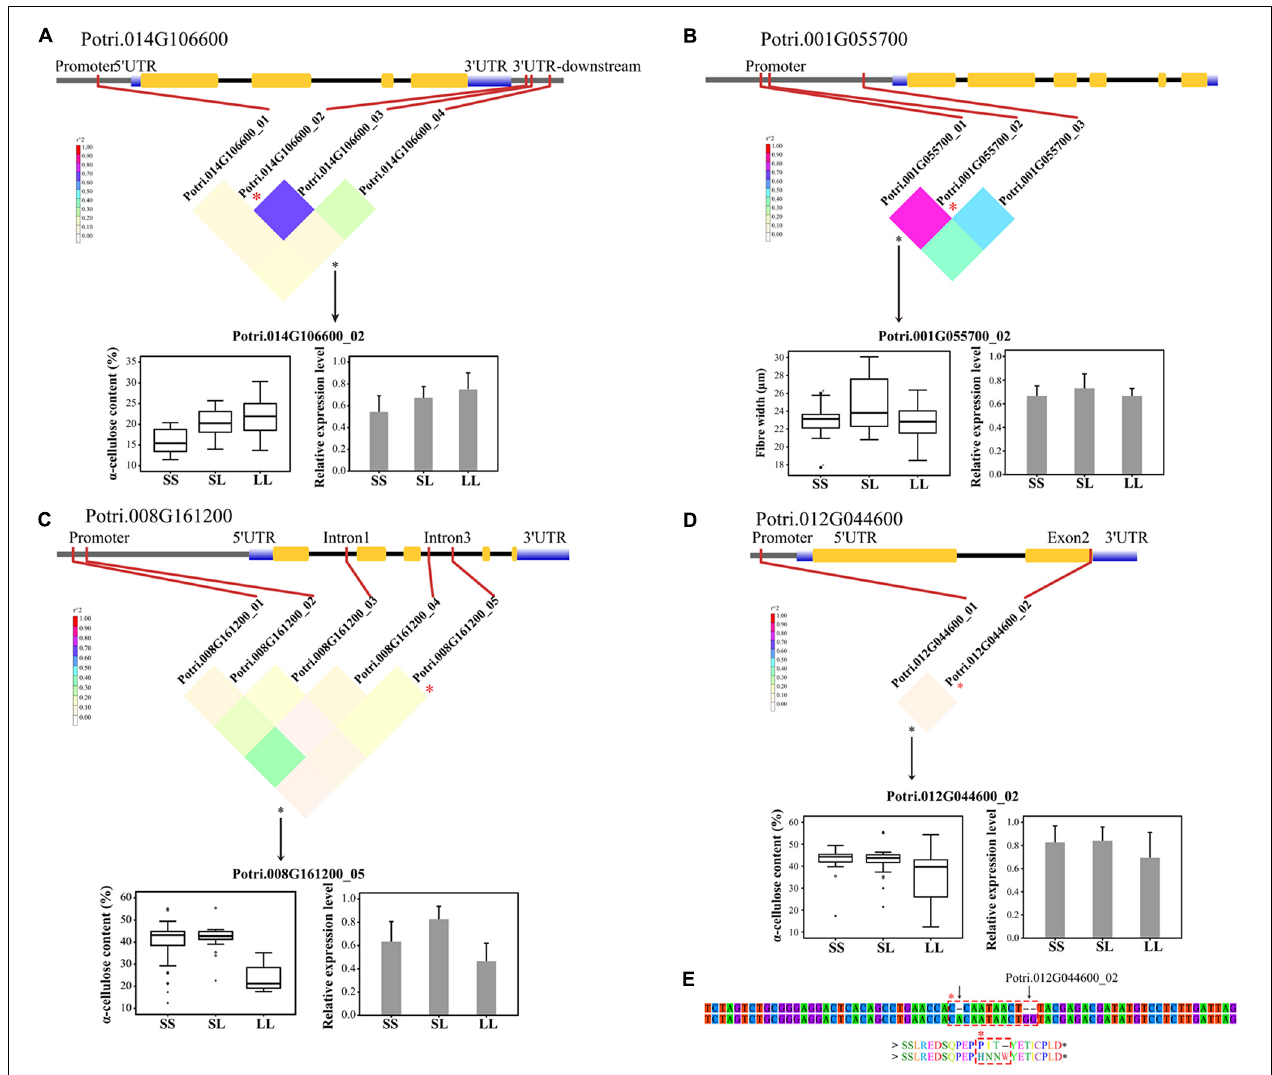
FIGURE 3 | Dissection of the regulatory InDels with additive and/or dominant effects in the P. tomentosa natural population. (A) A causal InDel (Potri.014G106600_02, T > TATTA) within the 3 (cid:48) UTR-downstream of Potri.014G106600 ( COMT ) showed a significant association with α -cellulose under additive effect. (B) A causal InDels (Potri.001G055700_02, A > AACCT) within the promoter region of Potri.001G055700 ( 4CL ) showed significant association with fiber width under dominant effect. (C) A causal InDel (Potri.008G161200_05, ATATATATAT > A) within the intron of Potri.008G161200 (similar to the indole-3-acetic acid protein, IAA ) showed a significant association with α -cellulose contents under additive and dominant effects. (D) A causal InDel (Potri.016G090300_02, T > TGG) within exon 2 of Potri.012G044600 (a receptor-like kinase) showed a significant association with α -cellulose content under additive effect. (E)